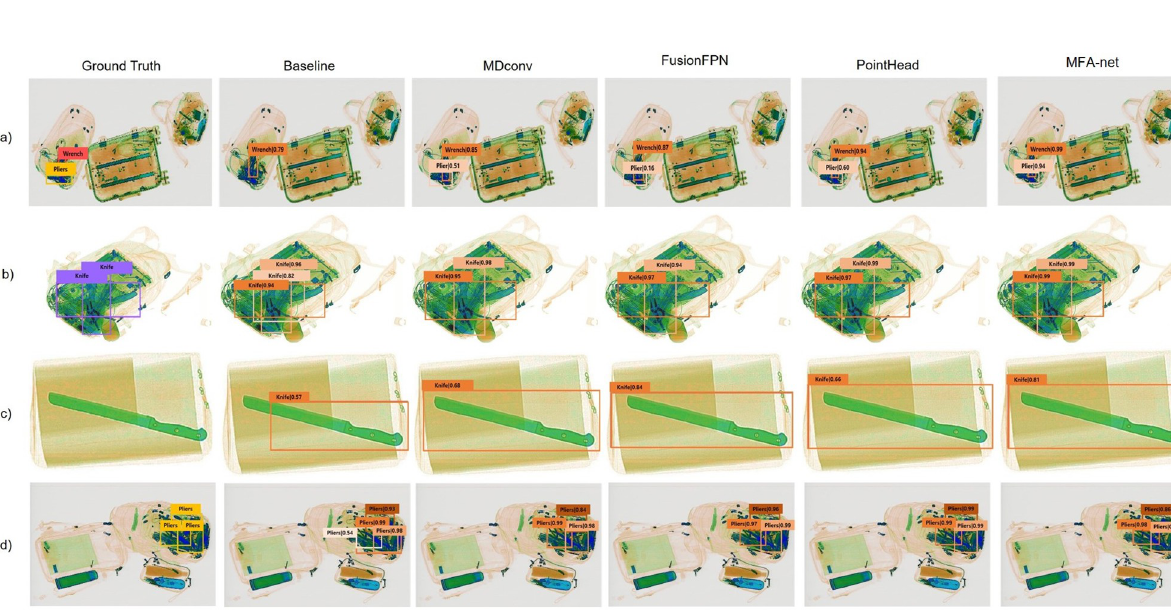
PLOS ONE | https://doi.org/10.1371/journal.pone.0272961 September 1,